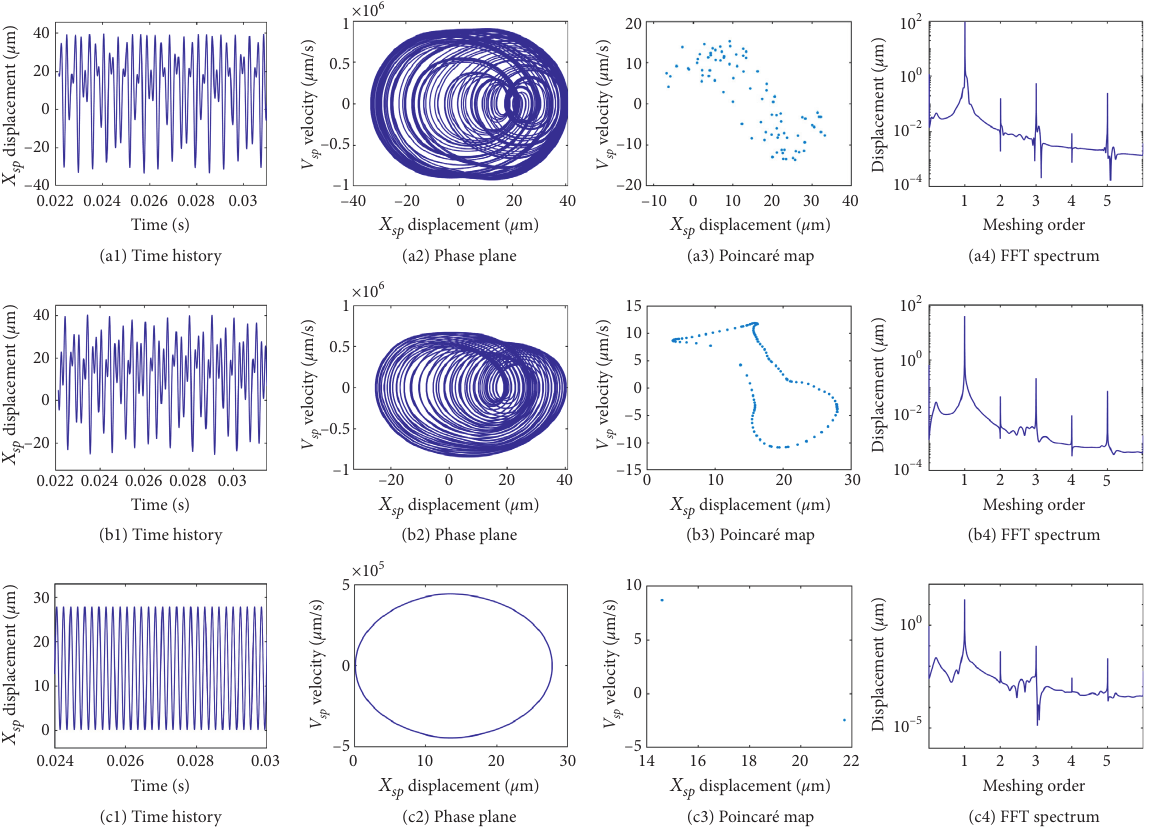
Figure 12: Vibration response of sun gear and star gear meshing pair. (a) ξ � 0 . 02, (b) ξ � 0 . 06, (c) ξ � 0 .